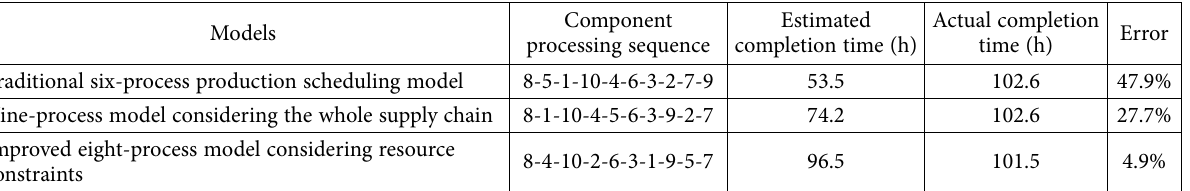
Table 2. Comparison of output results of three models